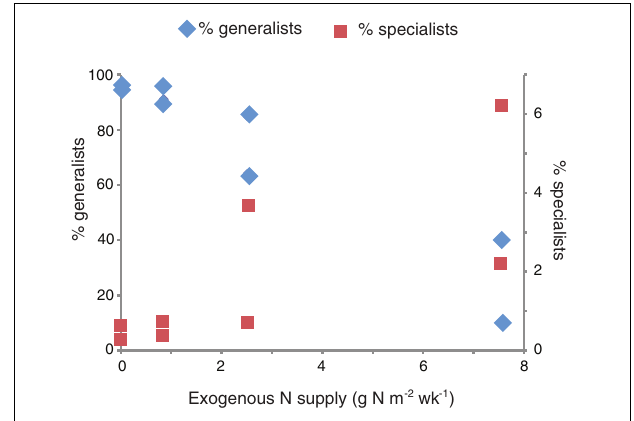
FIGURE 4 | Abundance of sequences in specialist vs. generalist taxa. Each value represents the total abundance of an OTU as a function of how many plots contained that sequence. The most abundant sequences were typically present in most, if not all, plots.